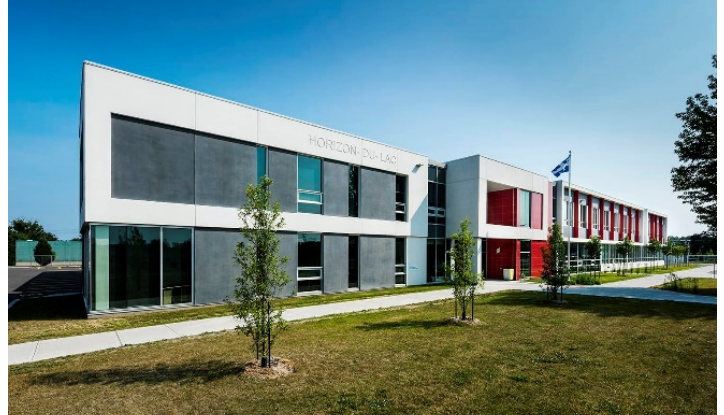
Figure 2. Electrically heated school building, Horizon-du-Lac (near Montreal, QC, Canada).